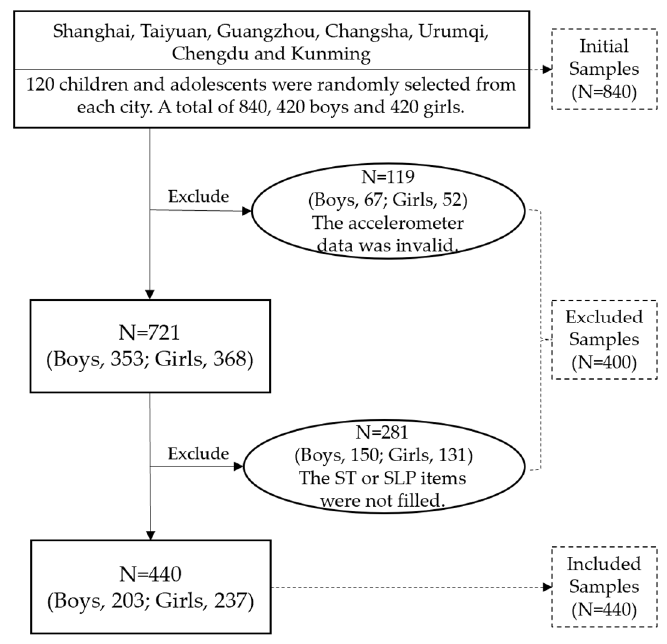
Figure 1. Flow chart of sample